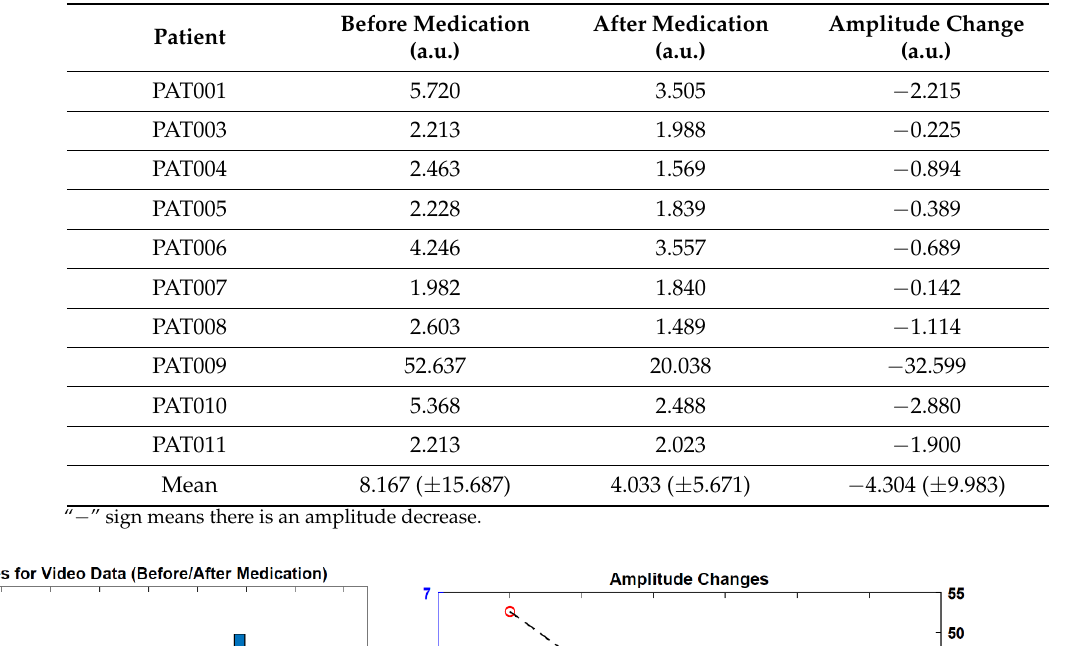
Table 6. Averaged amplitudes for video data.